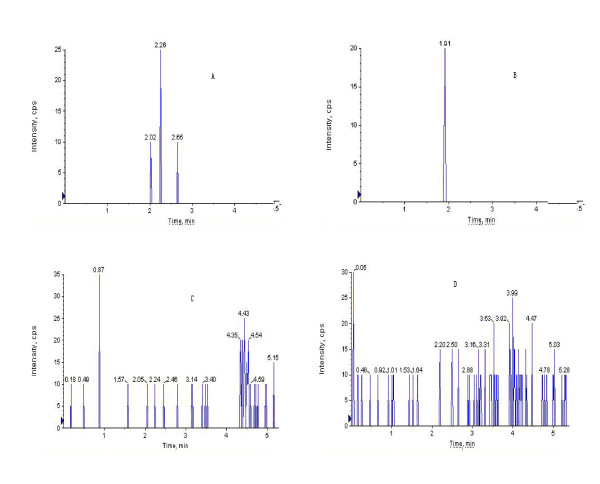
Typical LC/MS/MS chromatograms of blank plasma of beagle dog under our detecting conditions.